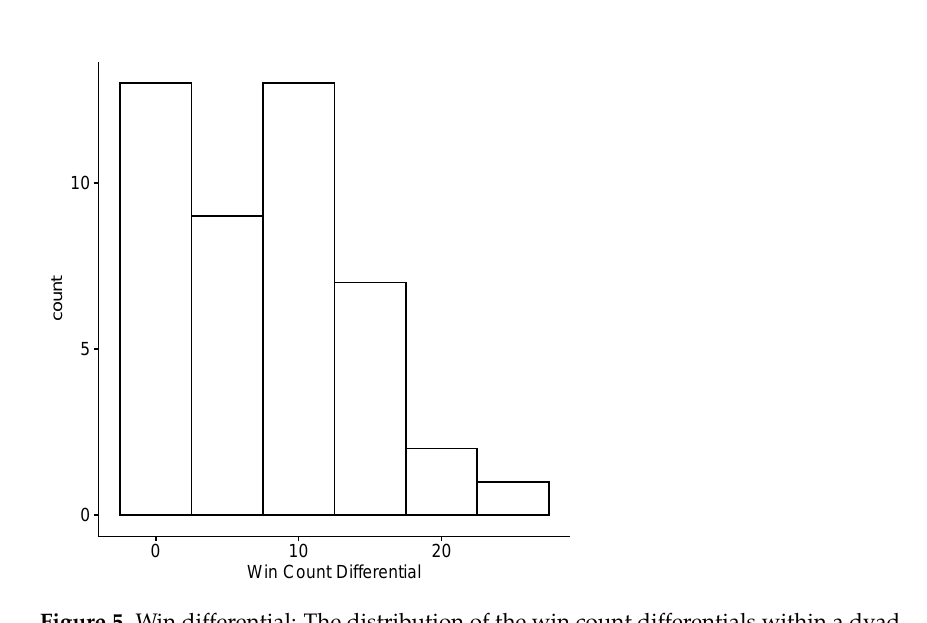
Figure 5. Win differential: The distribution of the win count differentials within a dyad.